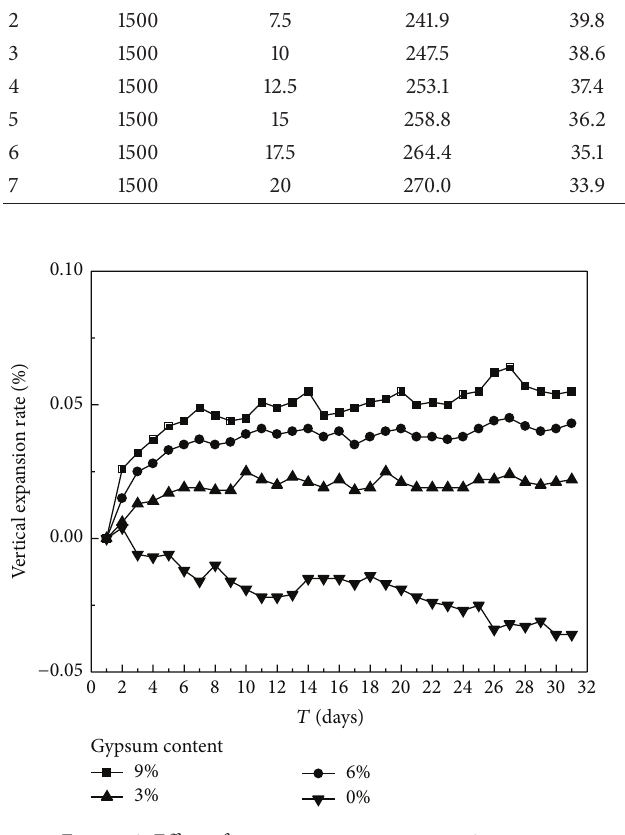
Figure 2: Effect of gypsum content on expansion rate. Figure 3: Effect of bauxite content on expansion